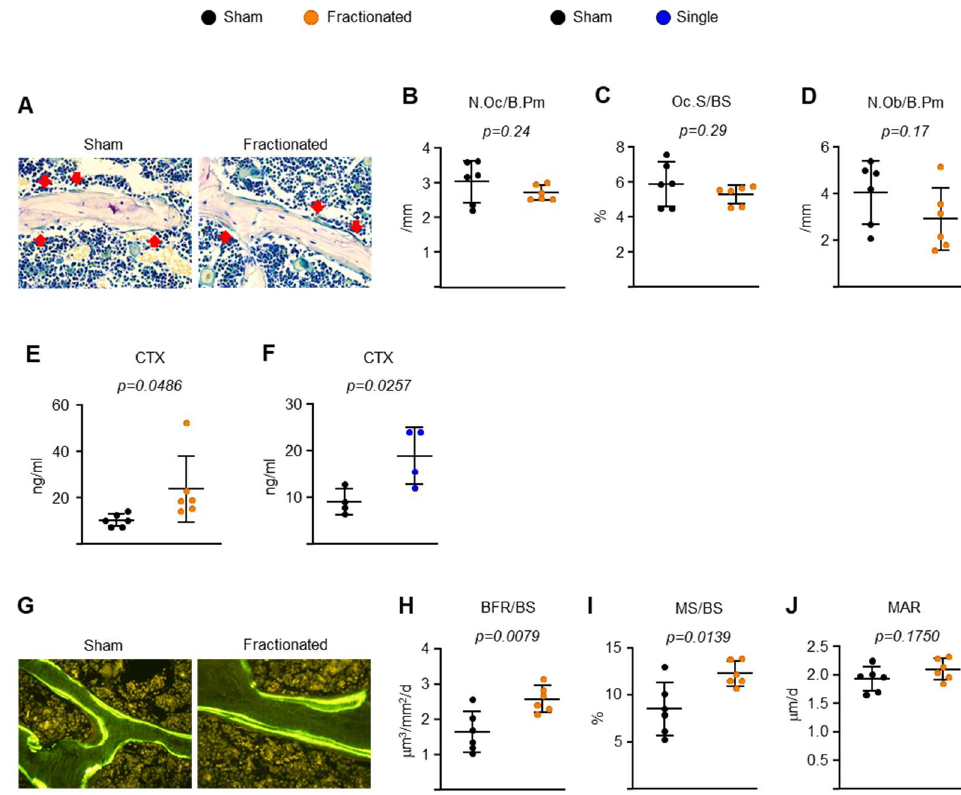
Figure 4. IR increases bone resorption in young adult male mice. ( A ) Representative photomicrographs of non-decalcified spine sections stained for TRAPase activity (red) from 8.5-month-old male C57BL/6 mice. ( B ) Number of osteoclast (N.Oc/B.Pm), ( C ) osteoclast surface, and ( D ) osteoblast (N.Ob/B.Pm) per trabecular bone surface ( n = 6 animals/group). ( E , F ) Serum concentration of a collagen degradation product (CTx) in ( E ) 8.5- and ( F ) 10-month-old male C57BL/6 mice by ELISA ( n = 4–6 animals/group). ( G ) Representative photomicrographs of trabecular bone surface labeled with tetracycline (fluorescent green) in undecalcified spine sections from 8.5-month-old male C57BL/6 mice. ( H ) Bone formation rate (BFR/BS), ( I ) mineralizing surface (MS/BS), and ( J ) mineral apposition rate (MAR) determined by tetracycline labels ( n = 6 mice/group, one section per mouse was analyzed). Data are presented as ±SD. p values were determined using Student’s t test.